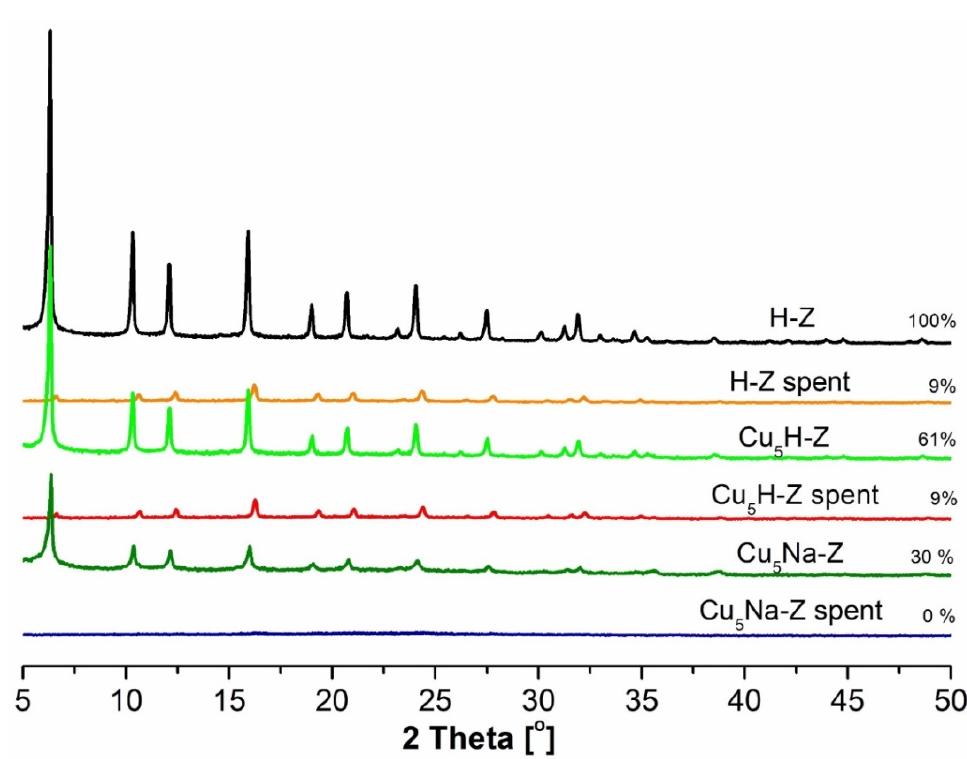
Figure A1. XRD images of the chosen samples before and after catalytic studies.